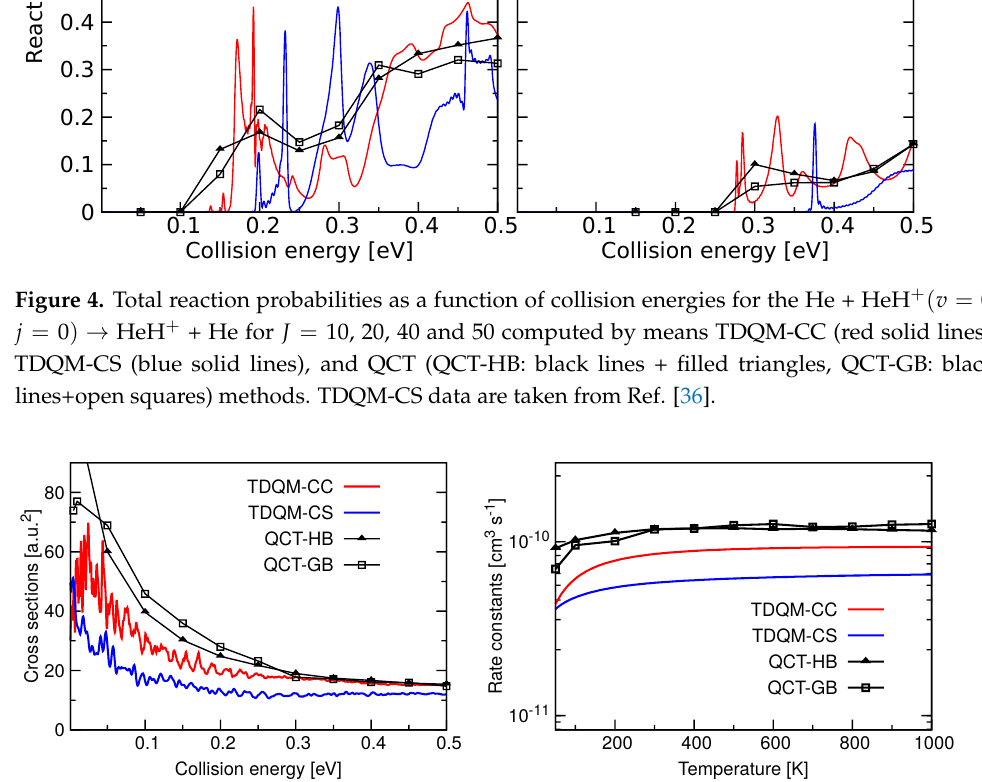
Figure 5. Total ICSs as a function of collision energy ( left panel ) and rate constants as a function of temperature ( right panel ) for the He + HeH + ( v = 0, j = 0 ) → HeH + + He calculated following TDQM CC (solid red solid line) and TDQM CS (blue solid line) and QCT (QCT-HB: black lines+filled triangles, QCT-GB: black lines+open squares)